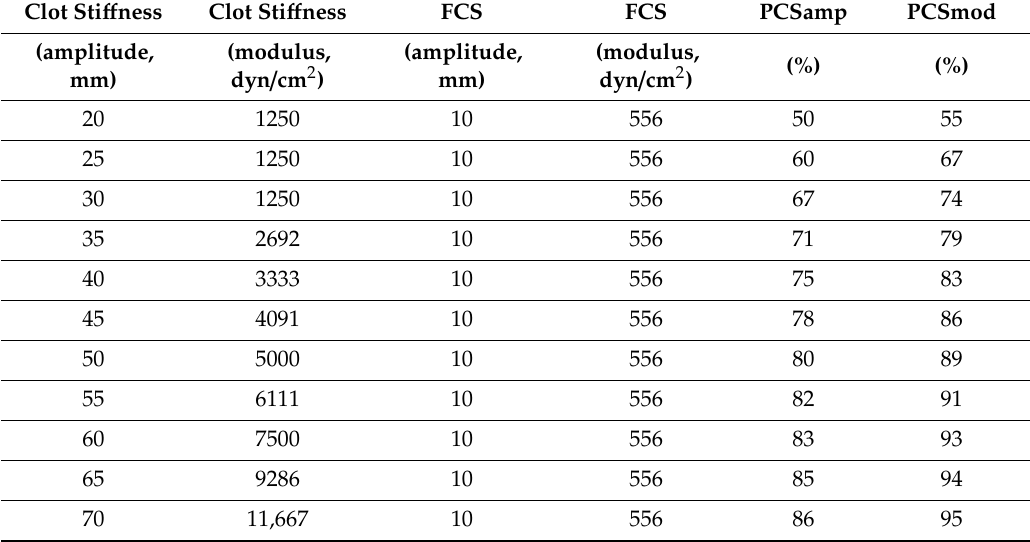
FCS: fibrinogen contribution to clot sti ff ness; PCSamp: platelet contribution based on di ff erence in amplitude; PCSmod: platelet contribution based on di ff erence in